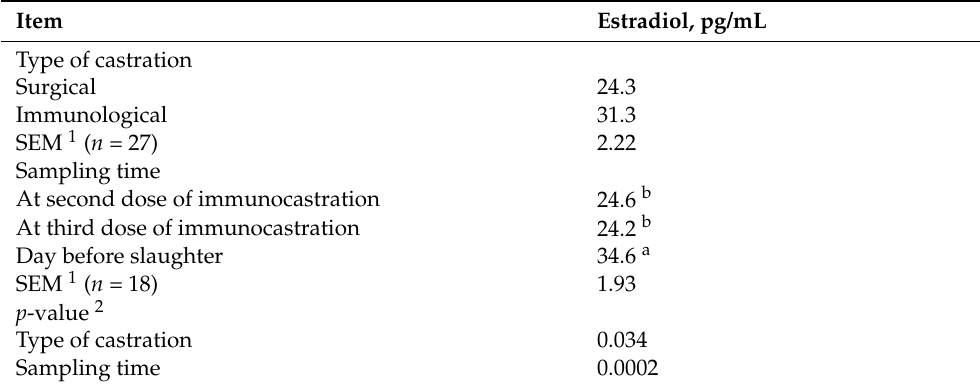
Table 3. Impact of type of castration and sampling time on the serum estradiol concentration (least square means) of heavy male pigs.